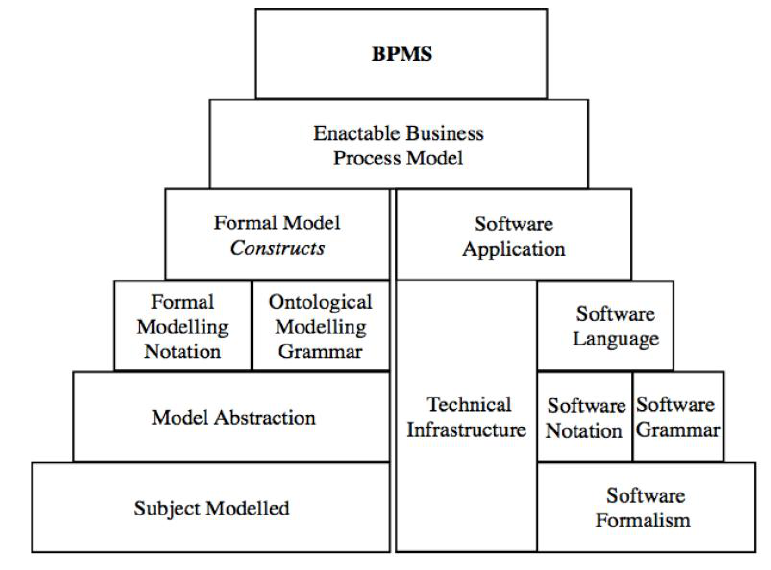
Figure 1. BPMS Pyramid Architecture [17]